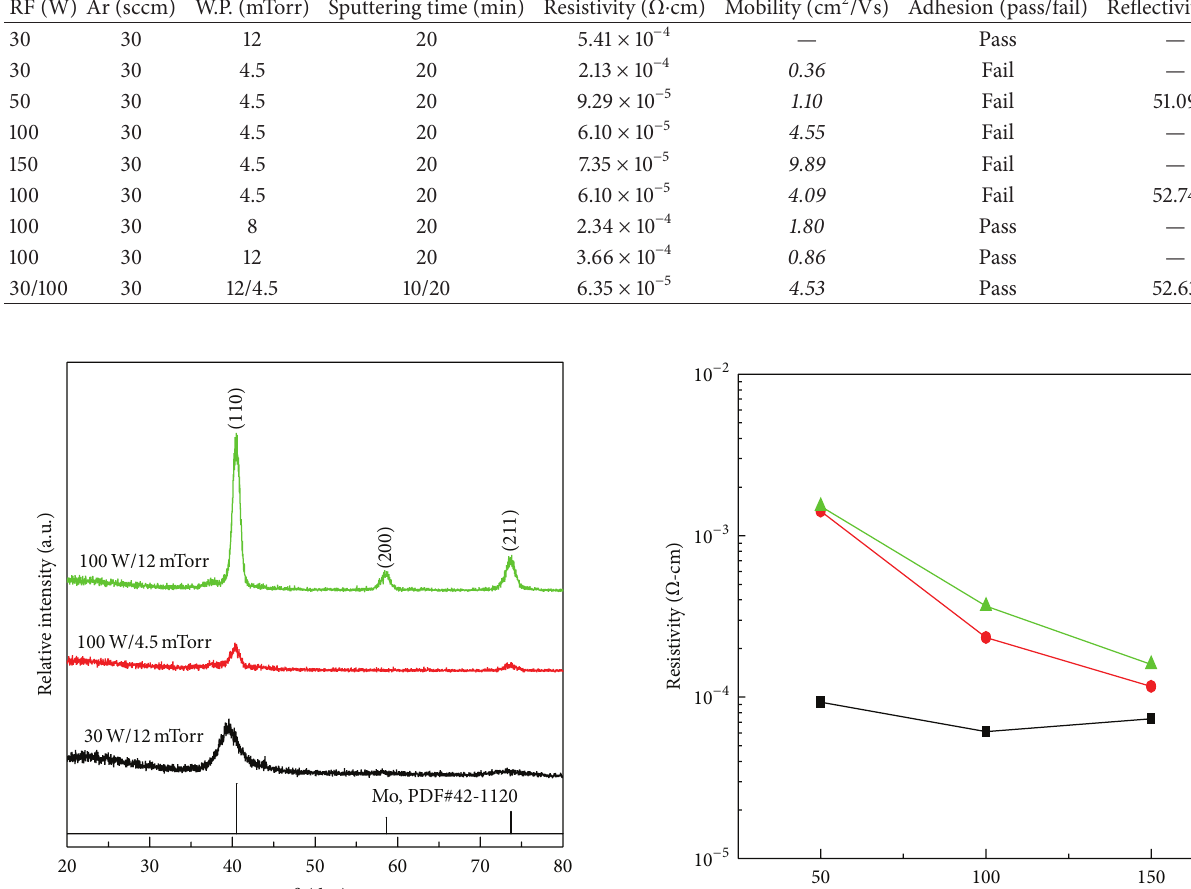
Table 1: Physical characteristics of Mo films prepared under different deposition conditions.